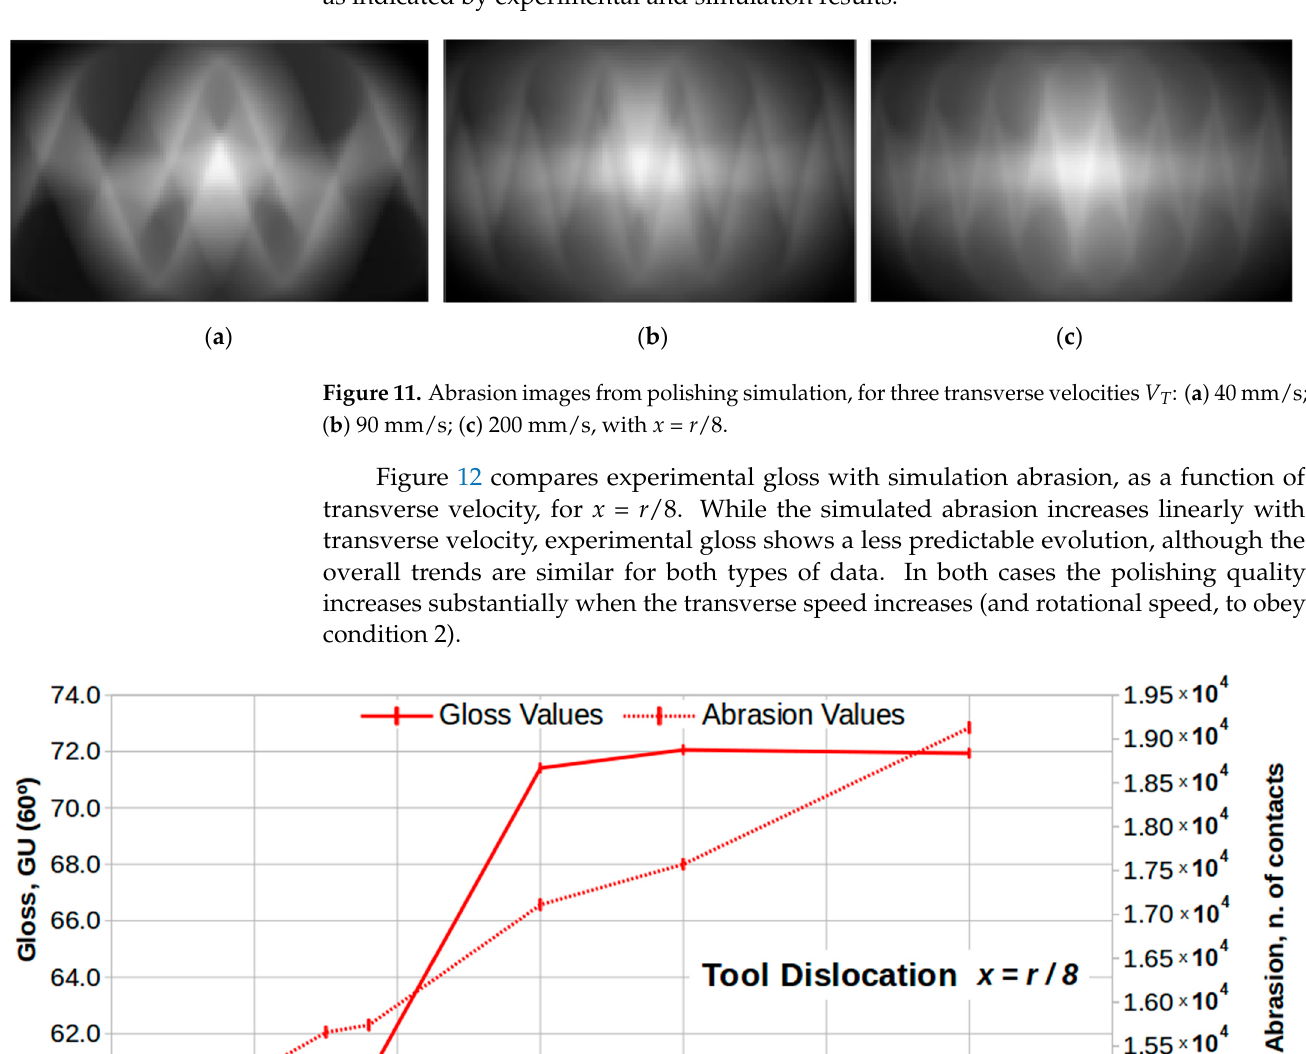
Figure 10. Abrasion as a function of transverse velocity V T , for x = r , x = r /2, x = r /4, and x = r /8.